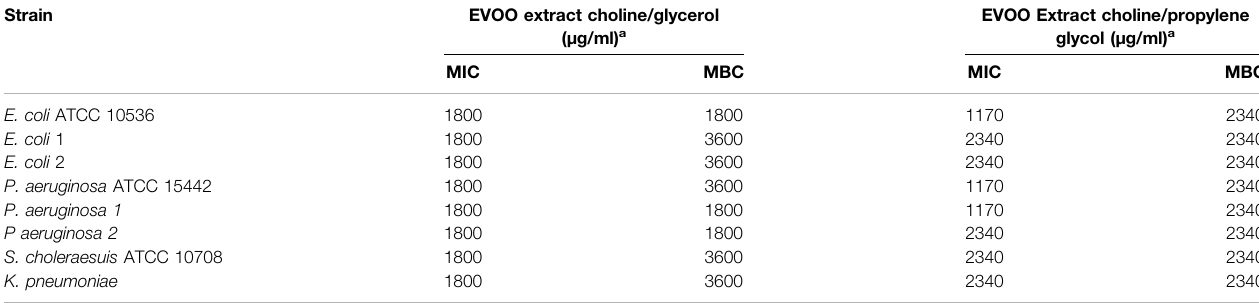
TABLE 4 | Antibacterial activity of EVOO extracts in NaDESs against Gram-negative standard strains and drug-resistant clinical isolates.